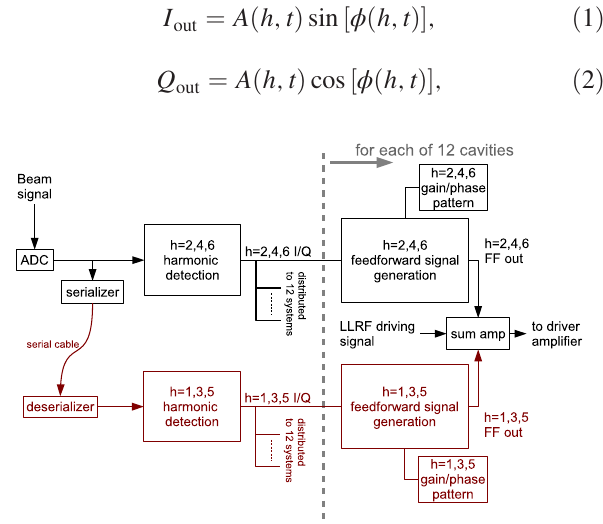
FIG. 1. The configuration of the additional feedforward system for the odd harmonics ( h ¼ 1 ; 3 ;